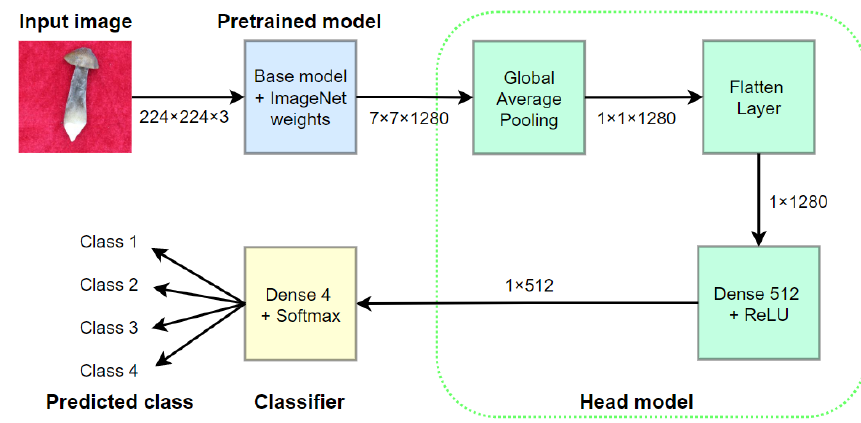
Figure 2. Four quality levels of Oudemansiella raphanipes. ( a ) Class 1; ( b ) Class 2; ( c ) Class 3; ( d ) Class